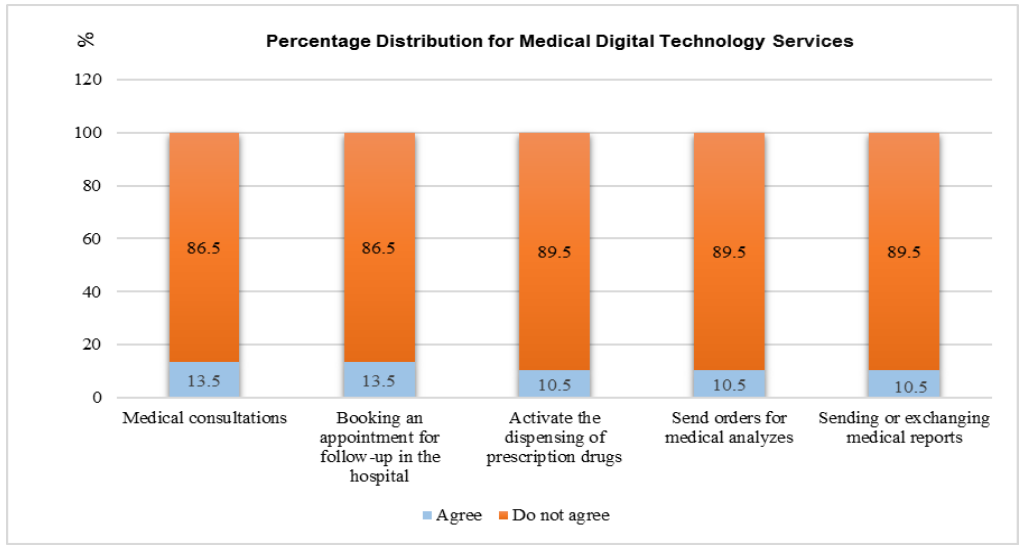
Figure 4. Services of medical digital technologies applications for patients in the study during the COVID-19 pandemic.